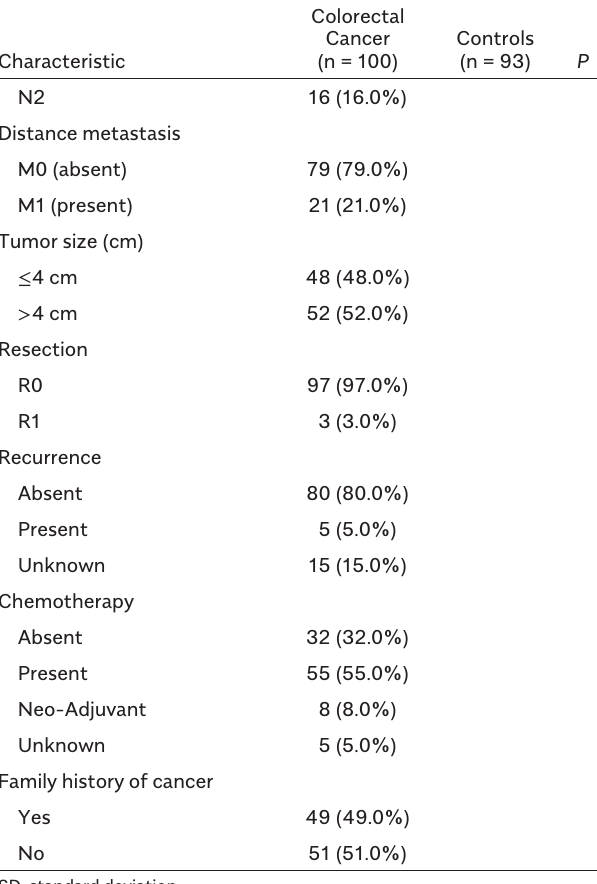
Table 1. Clinical Characteristics of Colorectal Cancer Cases and Control Subjects Enrolled in the Study ( Continued